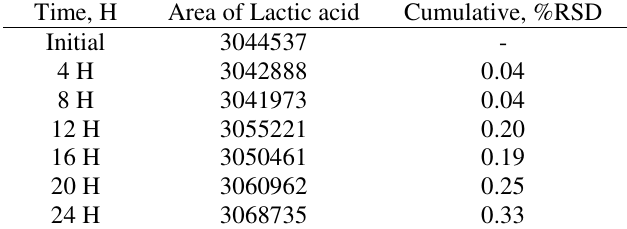
Table 5. Sample Solution stability